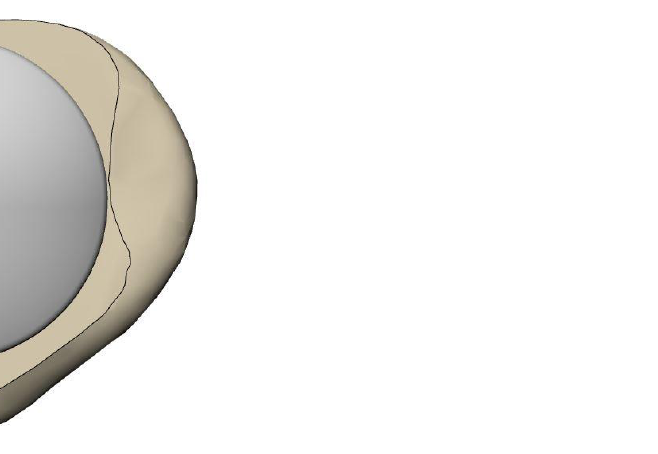
Figure 9. Statistical Shape Model of Patella resected at 6 mm and implanted with a universal patella (Aesculap, Tuttlingen, Germany). The implant peak (red) is 1.6 mm lateralized with respect to the native patella peak (blue).